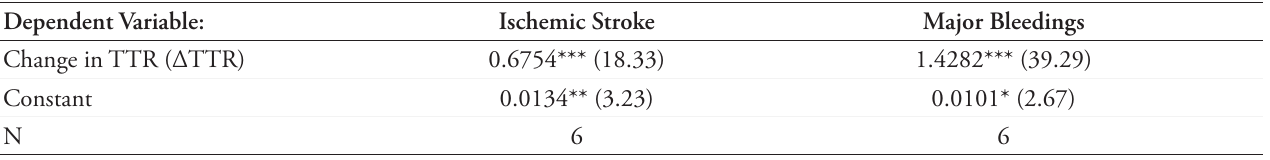
Table 2: Regression results derived from the data of Rose et al.15 Dependent Variable: Ischemic Stroke Change in TTR (ΔTTR)